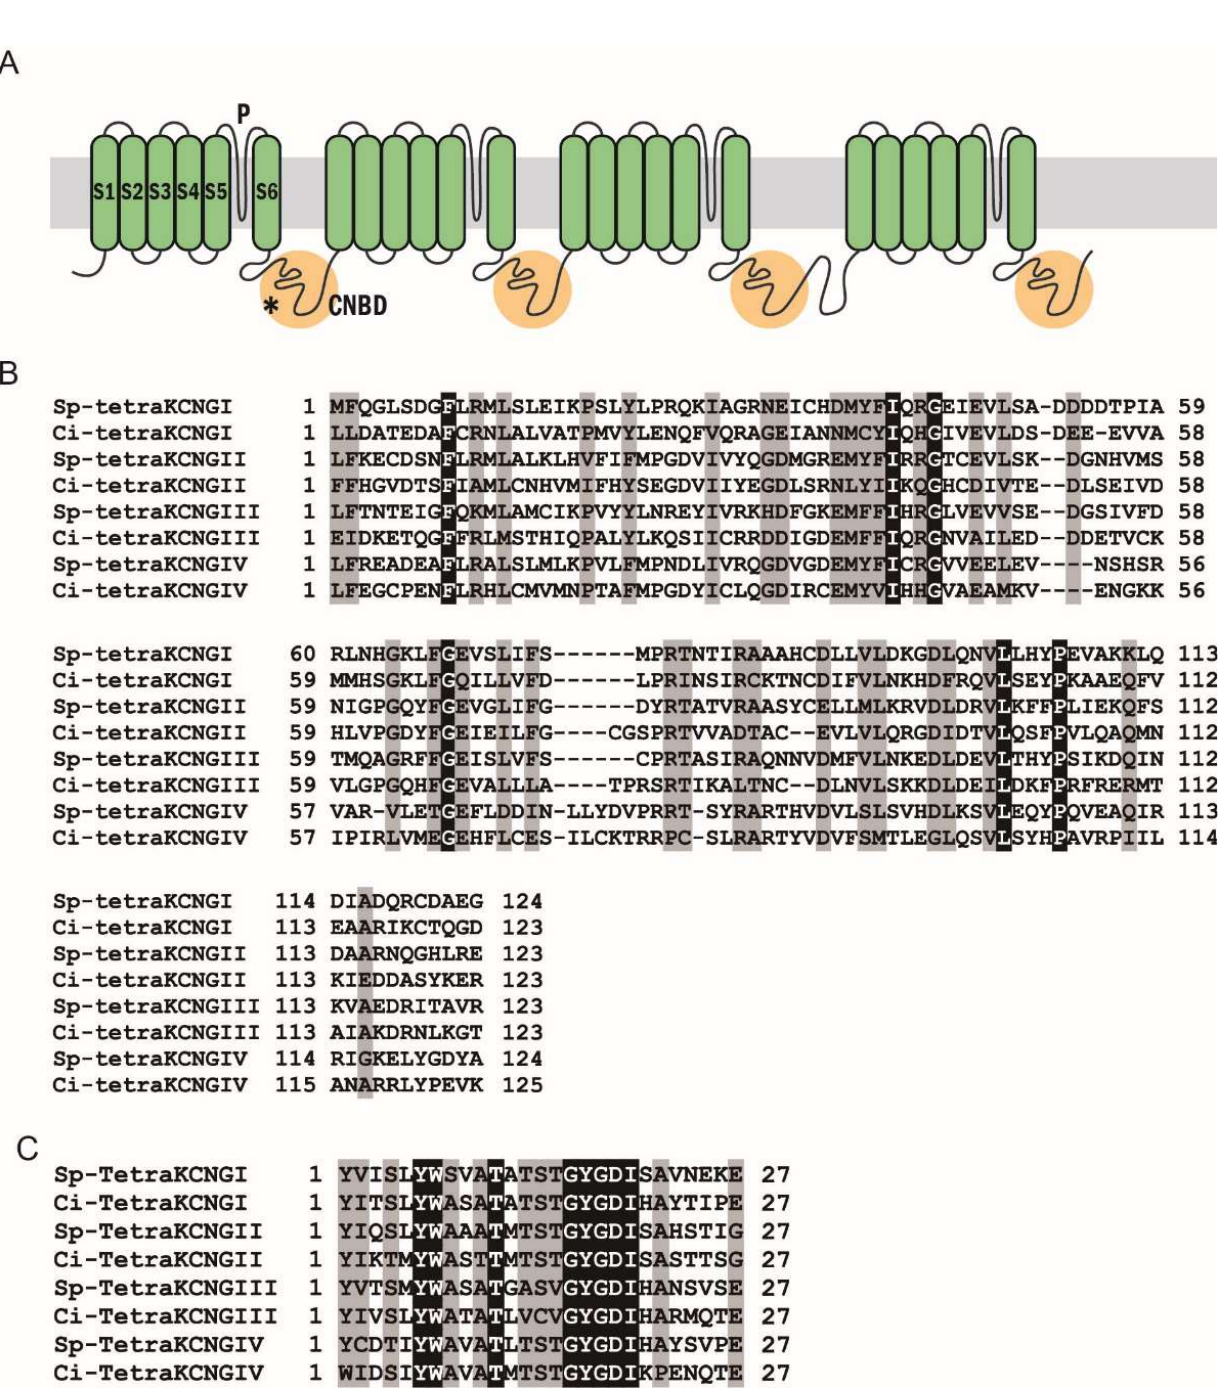
Figure 2. ( A ) Schematic representation of the tetraKCNG channel. * The asterisk shows the region used for the antigen to raise a polyclonal antibody. ( B ) Amino acid sequence alignment of the cyclic nucleotide-binding domain (CNBD) from the Sp-tetraKCNG channel and the Ci-tetraKCNG channel. The tetraKCNG channel identified in Ciona is very similar to the tetraKCNG channel in sea urchin. ( C ) Amino acid sequence alignment of the pore region.